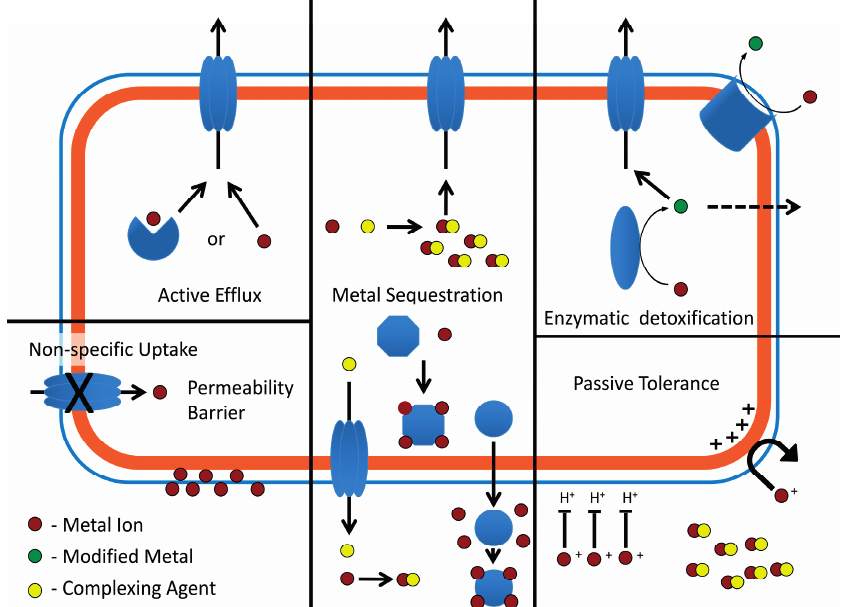
Figure 3. Overview of metal resistance mechanisms for acidophiles. Energy for transporters can be provided by ATP (P-type ATPase), proton gradient (RND), or chemiosmotic (CDF). Metal sequestration can occur through small molecule complexing agents (e.g., phosphate) or metal-chelating proteins. The exterior blue barrier represents some external permeability barrier (e.g., S-layer or biofilm). The figure does not including reduction in metal sensitivity of cellular